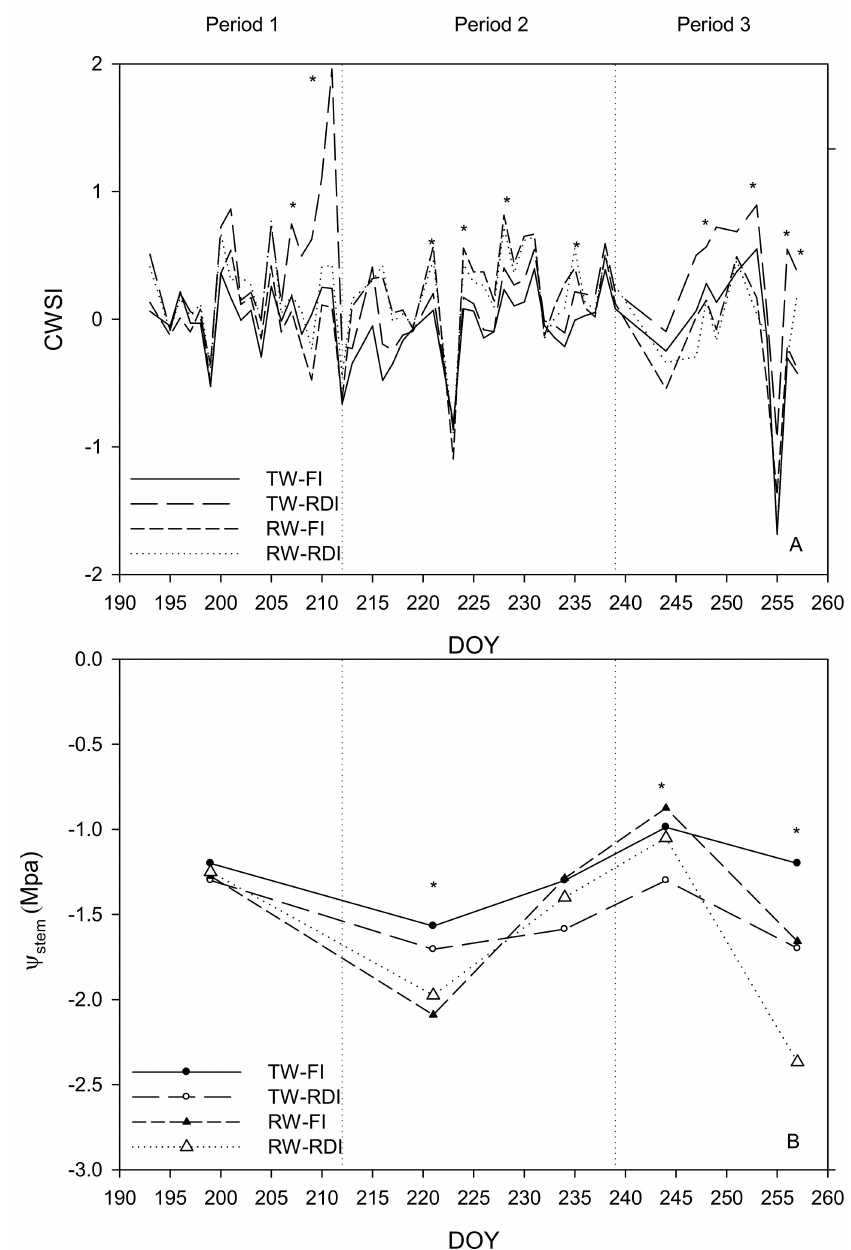
Figure 9. Evolution of ( A ) crop water stress index (CWSI) collected at 10.00 GMT and ( B ) stem water potential ( Ψ stem , MPa) for each treatment: TW-FI (transfer water-full irrigation), TW-RDI (transfer water-regulated deficit irrigation), RW-FI (reclaimed water-full irrigation), and RW-RDI (reclaimed water-regulated deficit irrigation) during the experimental period. Each value is the average of four individual measurements per tree and replicate. * Indicates significant differences among treatments, according to Tukey’s test ( P < 0.05). The discontinuous vertical lines divide the experimental period into three periods with a different water stress level: 1 (DOY 193-212), 2 (DOY 213-239), and 3 (DOY